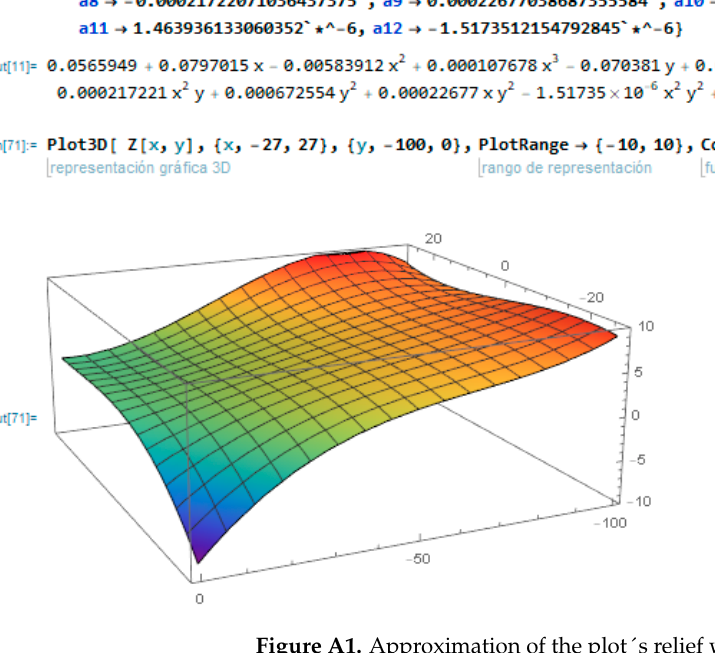
Figure A1. Approximation of the plot´s relief with an interpolating polynomial obtained previously with the least squares method.